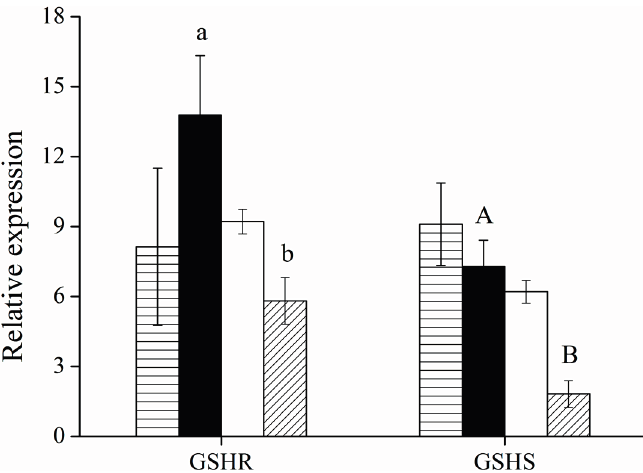
Figure 3. Relative mRNA expressions of glutathione reductase and glutathione synthetase were compared between transfectants and non-transfectants. Bars represent HepG2 without ( ▤ ) or with ( ■ ) Cr(VI) treatment, and HepG2-YieF without ( ▢ ) or with ( ▨ ) Cr(VI) treatment. The values are the mean of four individual samples. Data were normalized to the expression of the housekeeping gene β -actin . Differences between bar a and b and between A and B are significant ( p < 0.05).